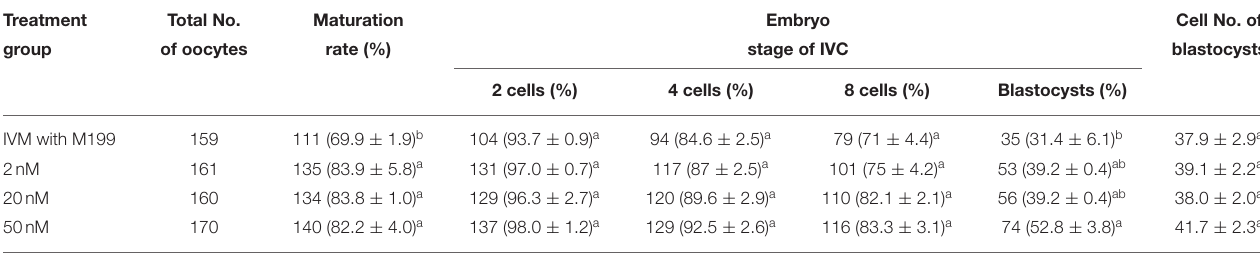
TABLE 6 | Effects of IVM media supplemented with miR-320a-3p on the development of parthenogenetic activation porcine embryos. Treatment Total No. Maturation Embryo Cell No. of group